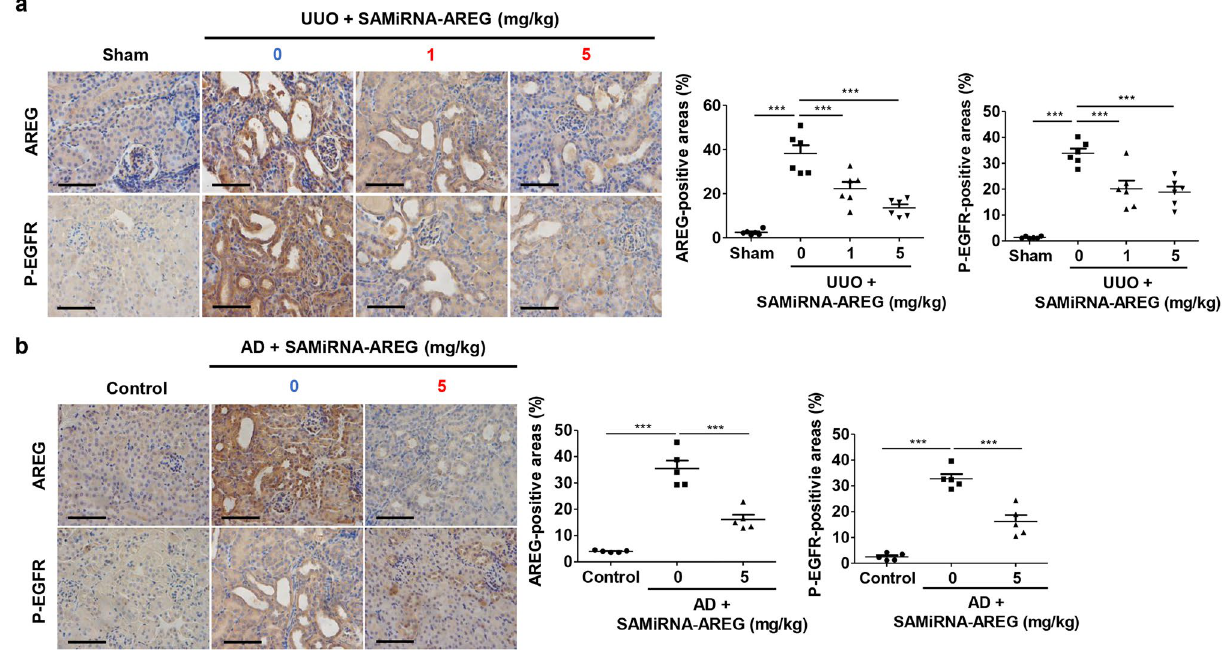
Figure 7. SAMiRNA-AREG inhibited EGFR phosphorylation by downregulating AREG in UUO- or AD-induced renal fibrosis. ( a , b ) Representative images of AREG expression and EGFR phosphorylation revealed overexpression in the UUO- or AD-induced models of renal fibrosis, which was attenuated by SAMiRNA-AREG administration (1 mg/kg or 5 mg/kg). The AREG- and p-EGFR-positive areas were